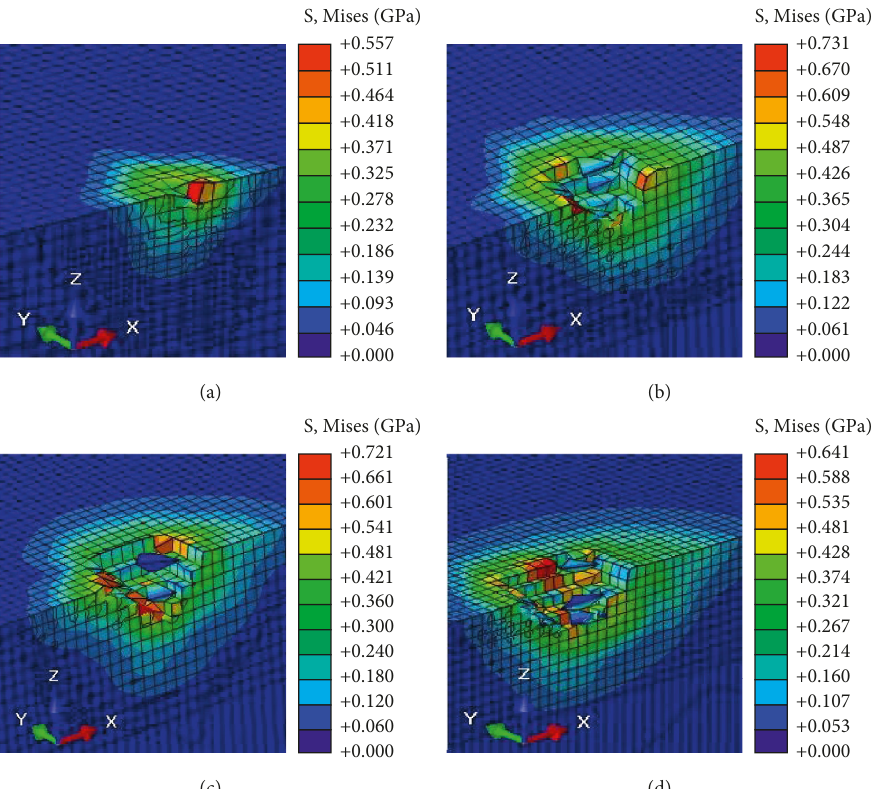
Figure 11: Impact stress contour impacted by tetrakaidecahedron particles with different equivalent diameters: (a) 50 μ m, (b) 120 μ m, (c) 160 μ m, and (d) 200 μ